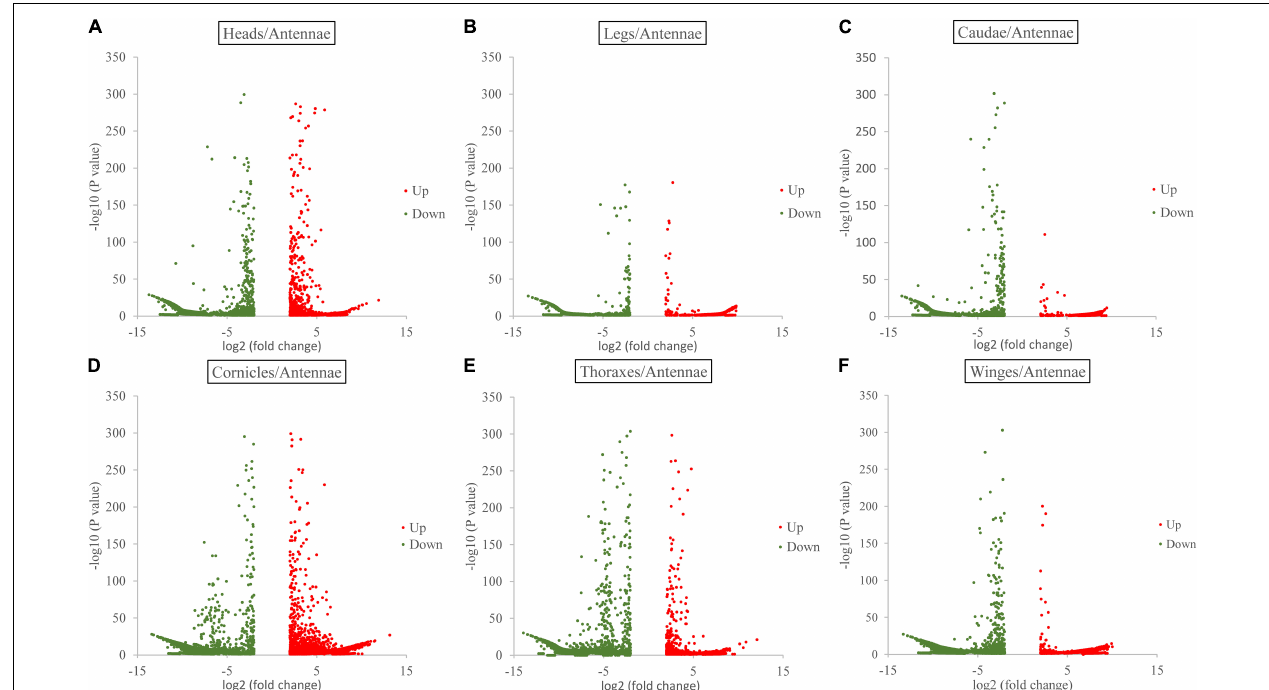
FIGURE 3 | Heatmap of 12 OBPs ( OBP2-10 , OBP13-15 ) FPKM values from the transcriptomes of 7 tissues and organs (antennae, heads, wings, legs, thoraxes, caudae, and cornicles). (A–F) were the heatmap result of 12 OBPs FPKM values in heads, legs, caudae, cornicles, thoraxes, and wings, respectively.